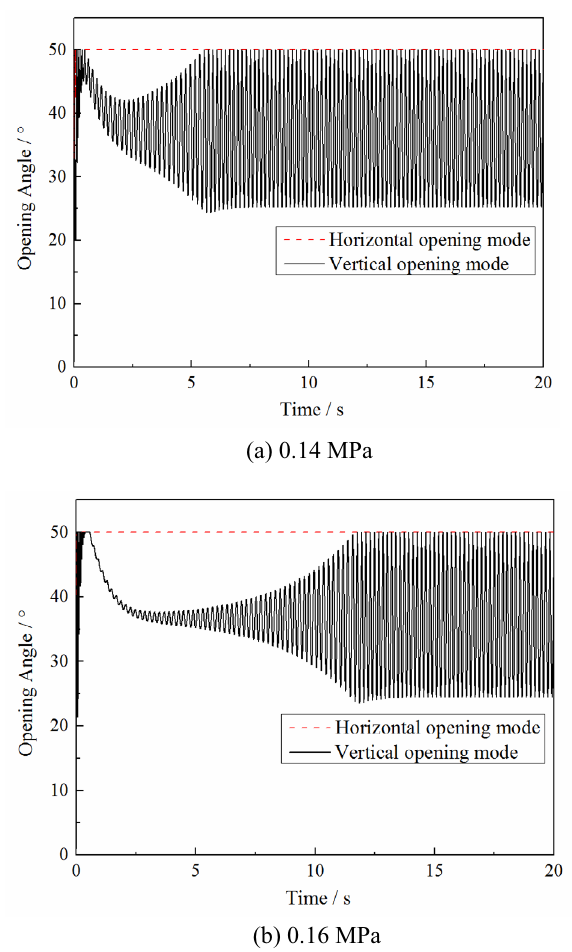
Figure 4. Effects of different opening modes on the changes of the opening angle under different opening